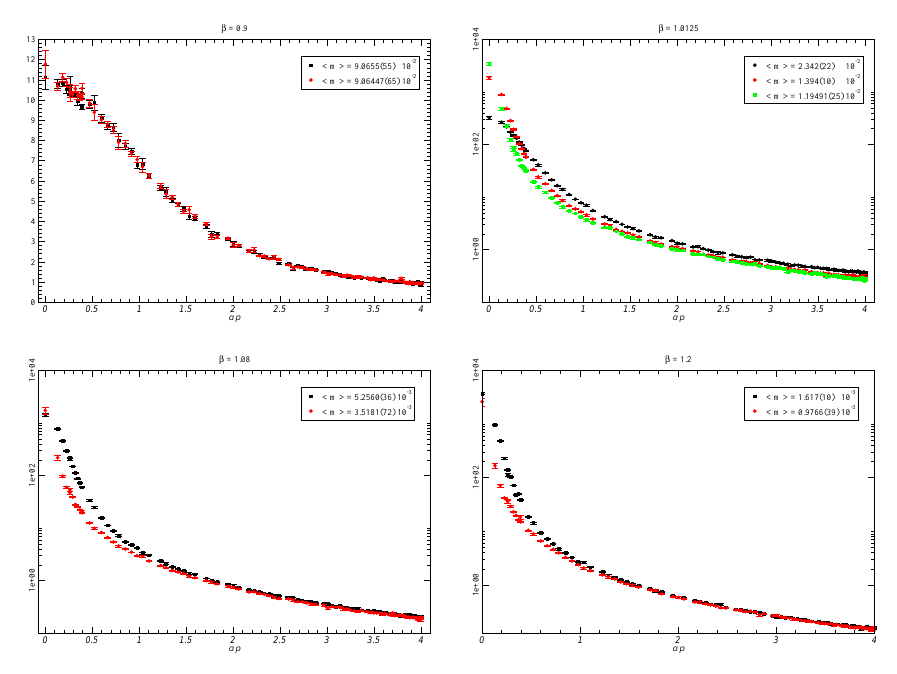
Figure 3. The photon propagator for several β computed from di ff erent Markov chains. < m > stands for value averaged over the lattice for each configuration of m µν . See [2] for further